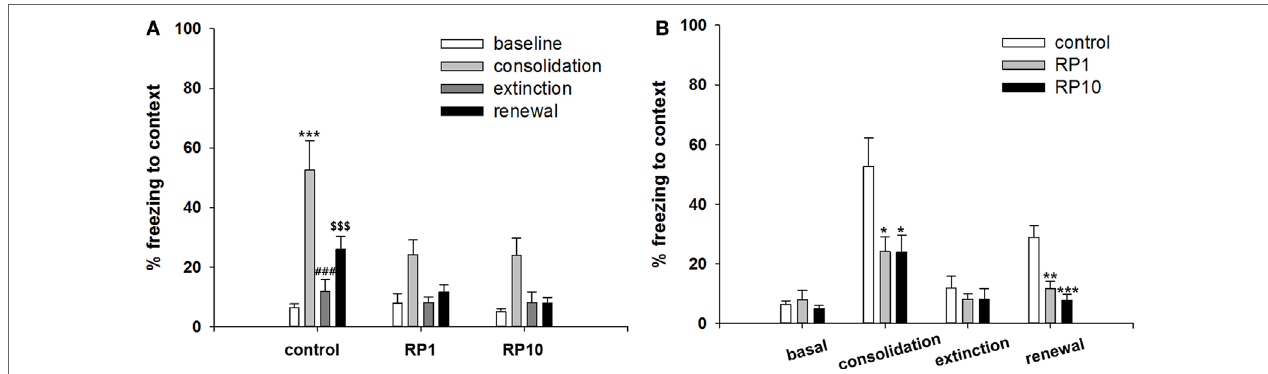
FigUre 4 | The effect of Radix Polygalae (RP) on contextual fear memory consolidation, extinction and renewal. Repeat measure analysis of variance (ANOVA) showed within-group (procedure) effect [ F (3, 81) = 27.5, p < 0.001, η 2 = 0.505], between-group (treatment) effect [ F (2,27) = 5.3, p = 0.011, η 2 = 0.282] but no within–between interaction [ F (6, 81) = 1.7, p = 0.14, η 2 = 0.110]. (a) Within-group comparison of % freezing. In control group, fear memory was acquired (baseline vs. consolidation, p < 0.001), extinct (consolidation vs. extinction, p < 0.001), and renewed (extinction vs. renewal, p < 0.001). In RP1 and RP10 group, fear acquisition, extinction and renewal were all non-significant. *** p < 0.001 vs. baseline. ### p < 0.001 vs. consolidation. $$$ p < 0.001 vs. extinction. (B) Between-group comparison of % freezing. Consolidated fear were lower in RP1 ( p = 0.027) and RP10 ( p = 0.026) compared by controls. Renewed fear were also lower in RP1 ( p = 0.001) and RP10 ( p < 0.001) compared by control. There were no difference in the baseline and extinct level of fear response. * p < 0.05, ** p < 0.01, and *** p < 0.001 vs. control. Data represent mean ± SEM. control: DW; RP1: Radix Polygalae 1 mg/kg p.o. 10 days; RP10: Radix Polygalae 10 mg/kg p.o. 10